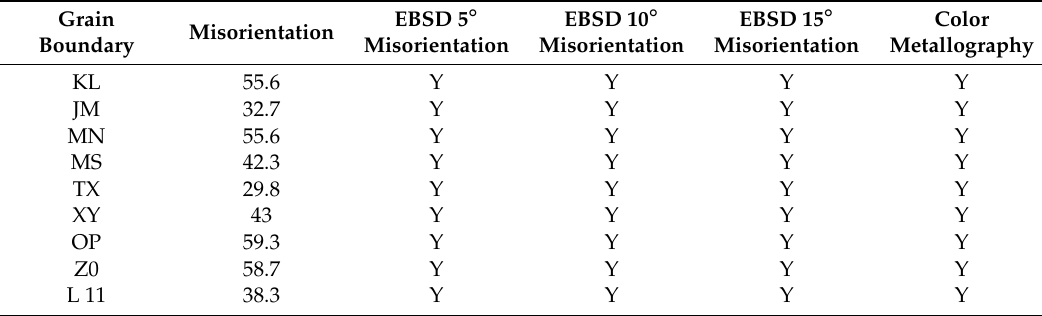
Table 2. EBSD data for thixocast sample, copper mold, poured at 630 ◦ C (Y, Yes; N,